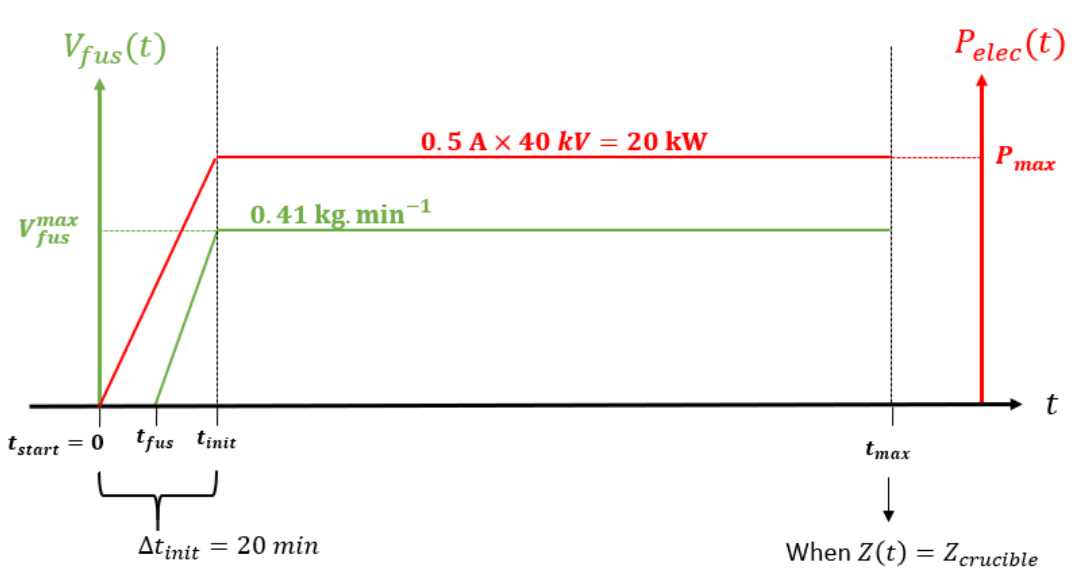
Figure 3. Set-up of the water-cooled copper crucible. Picture of the crucible ( a ); top view (XY) of the crucible and locations of the thermocouples ( b ). Table 1. Locations of the thermocouples.